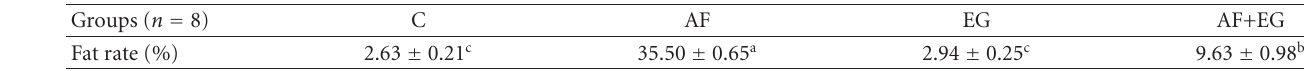
Table 2: Fat rate in hepatocytes (%).